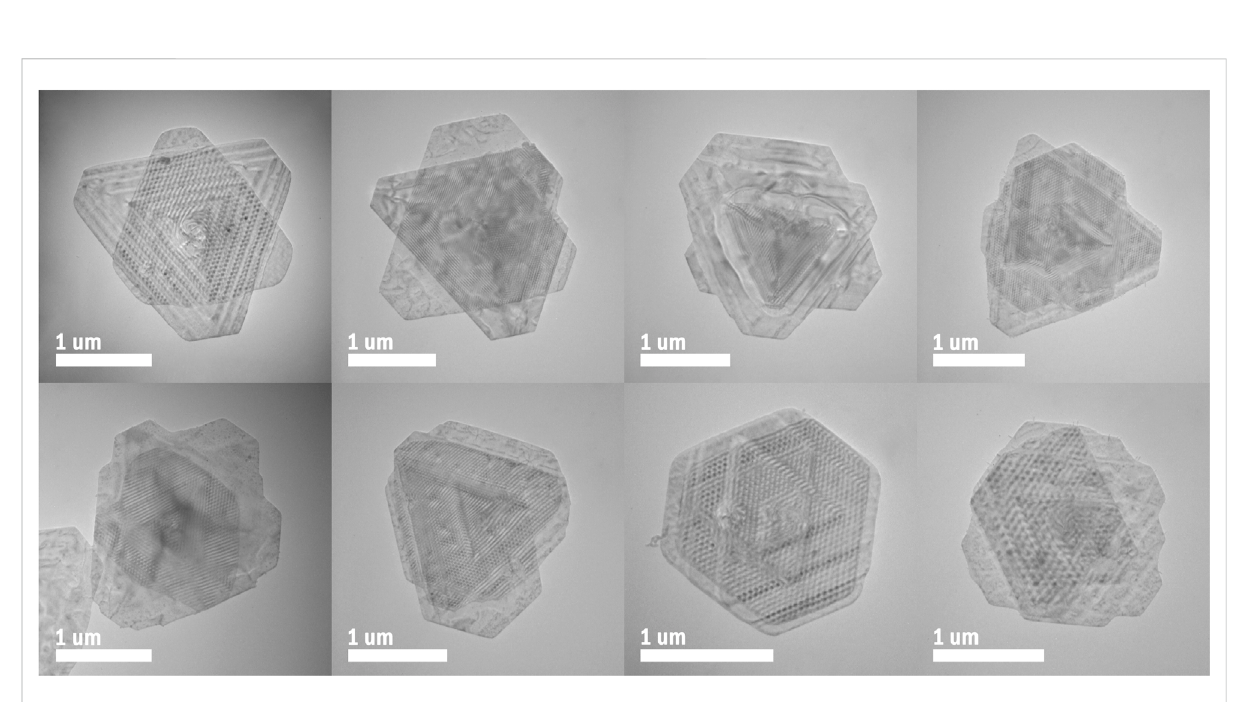
FIGURE 4 TEM images of Sb 2 Te 3 spiral nanoplates, each with a visible moiré